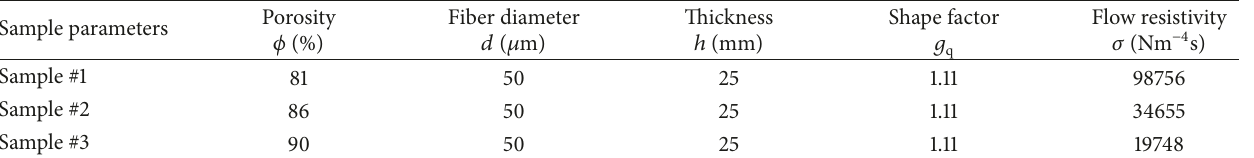
Table 3: The physical parameters of the PFMM samples and experimental results of static flow resistivity. Sample parameters